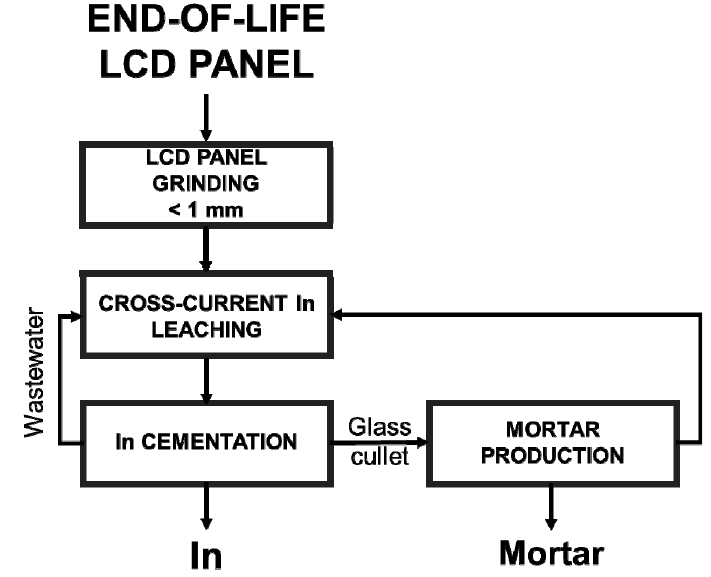
Figure 2. The entire process for the recovery of indium and glass from the end-of-life LCD panel.